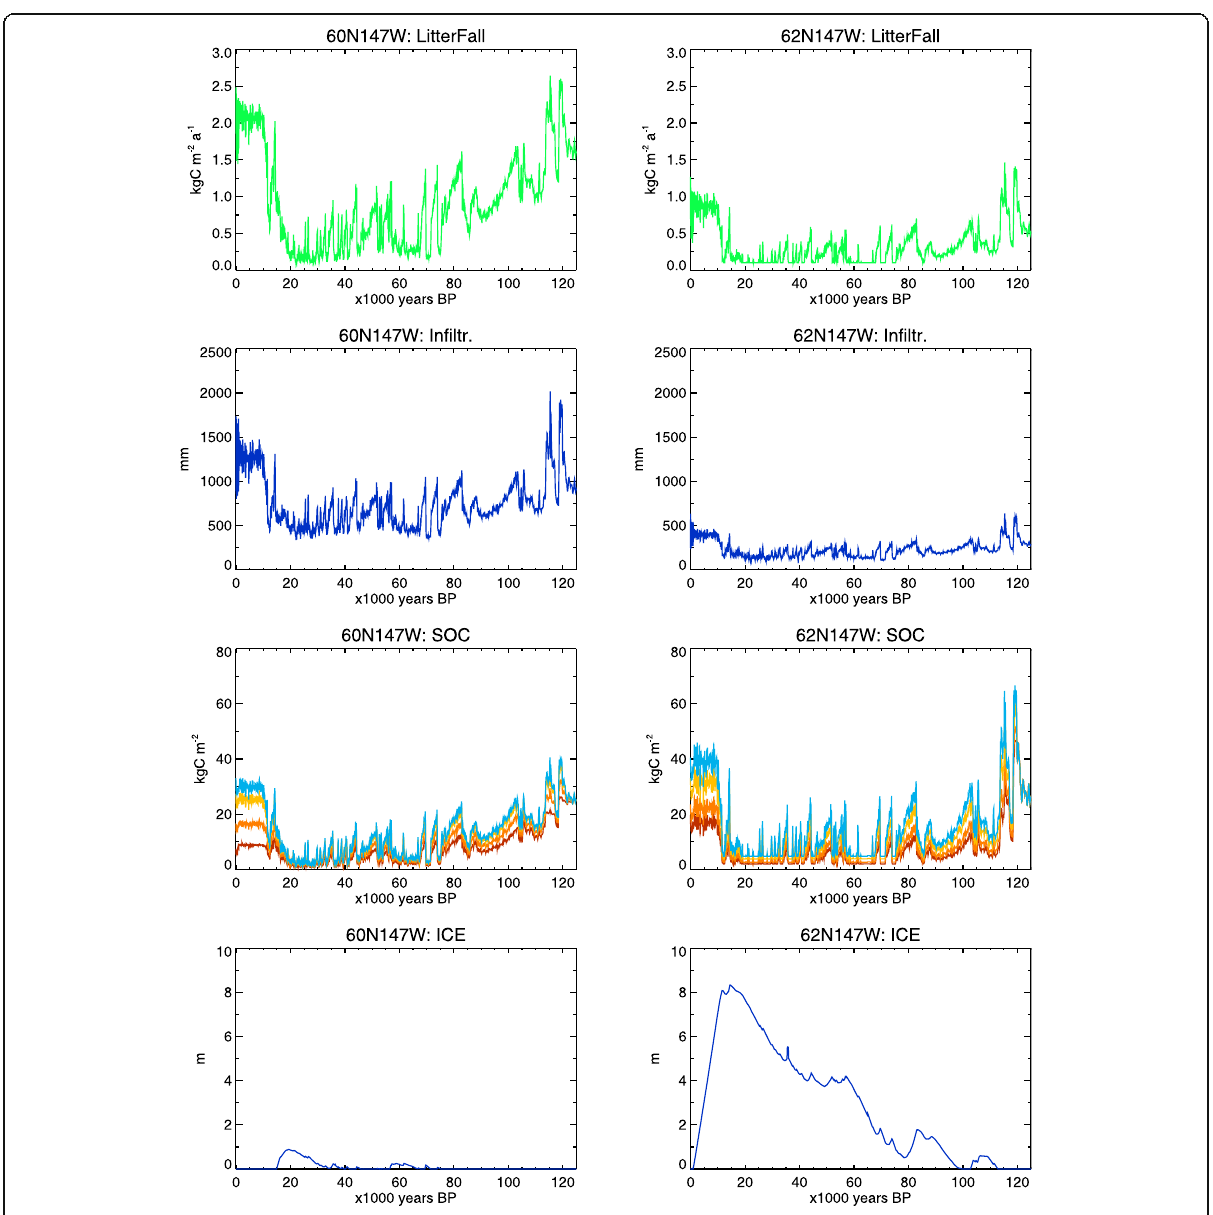
Fig. 4 Example simulation results of litterfall, infiltration, SOC, and ICE for the areas (60° N, 147° W, left column) and (62° N, 147° W, right column) for the 125 thousand years. The colors in SOC denote the value of τ (years): 5 (red), 20 (orange), 100 (yellow), and 500 (light